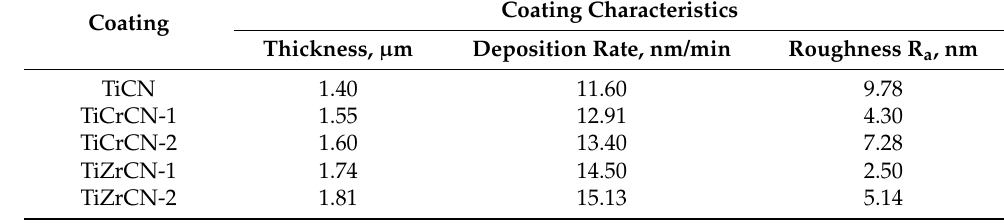
Table 3. Value of the thickness, deposition rate, and roughness for the deposited coatings. Coating